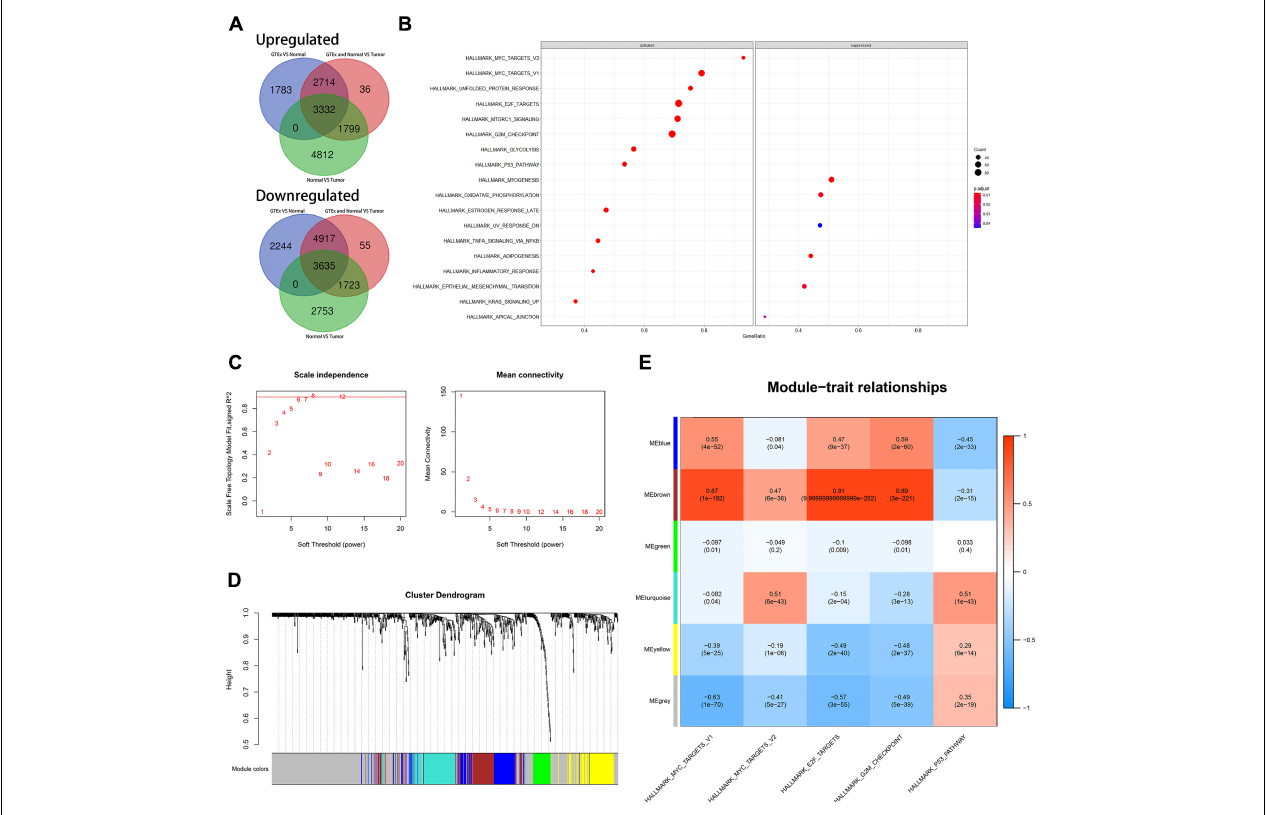
FIGURE 5 | Identification of latent biological pathways that might mainly be involved in the process of CRC and identification of cell cycle-associated genes. (A) The number of intersected differentially expressed genes among diverse comparative groups. (B) A gene set enrichment analysis (GSEA) of intersected differentially expressed genes among diverse comparative groups. (C) Confirmation of suitable soft-thresholding power to construct a scale-free network. (D) Identification of co-expression models and assignments of the corresponding color. (E) Correlation analysis between modules and relevant parameters.